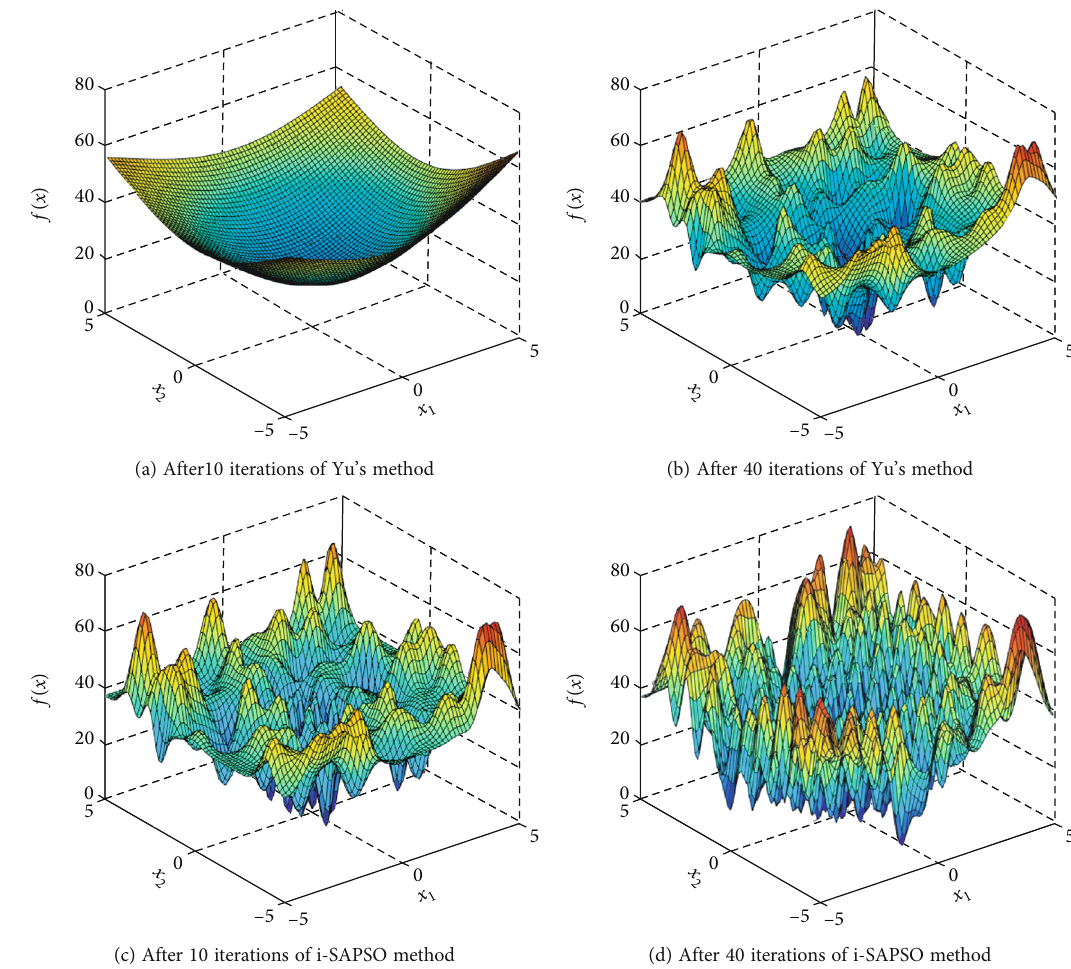
Figure 2: Evolution of surrogate